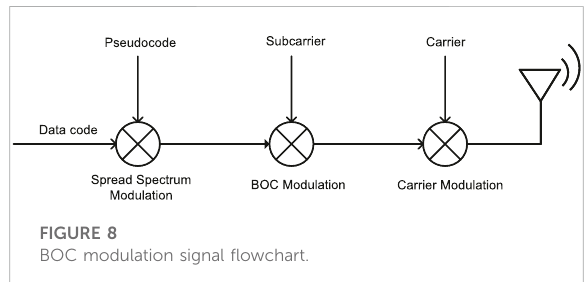
FIGURE 8 BOC modulation signal fl